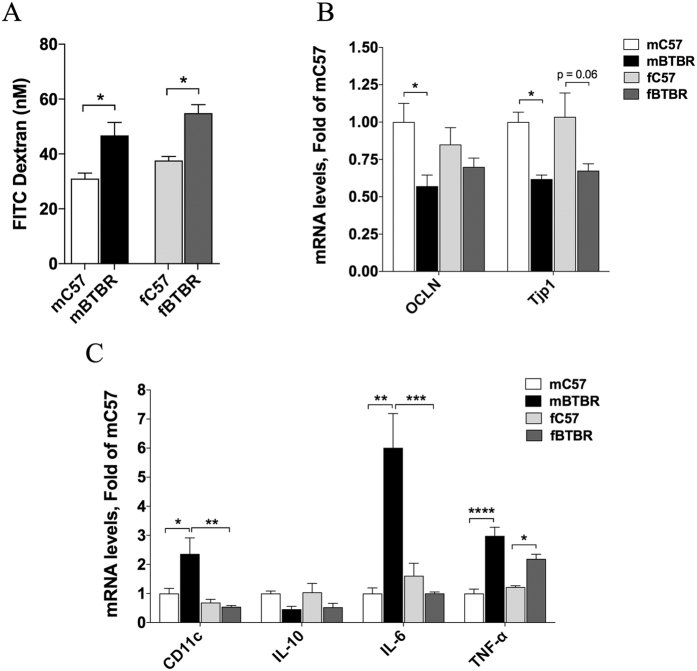
Analysis of intestinal integrity and inflammation levels in female and male BTBR mice.(A) Intestinal epithelial permeability to fluorescein isothiocyanate (FITC)-dextran 4 kDa of BTBR and C57 mice of both sexes. Data are represented as plasma concentration of FITC dextran (nM) (n = 5/group; p = 0.0002 for strain, p = 0.0469 for sex and p = 0.8187 for strain x sex, by two-way ANOVA). (B) Colon occludin (OCLN) and zonuline-1 (Tjp1), gene expression normalized to GAPDH gene in BTBR and C57 mice of both sexes. Data were normalized to mC57 control (n = 6/group; OCLN: p = 0.0067 for strain, p = 0.9105 for sex and p = 0.1623 for strain x sex; Tjp1: p = 0.0004 for strain, p = 0.6202 for sex and p = 0.9105 for strain x sex, by two-way ANOVA). (C) Colon mRNA levels of inflammatory markers (CD11c, IL-10, IL-6 and TNF-alpha) normalized to GAPDH in BTBR and C57 mice of both sexes. Data for each gene were normalized to mC57 controls (n = 6/group; CD11c: p = 0.0529 for strain, p = 0.0018 for sex and p = 0.019 for strain x sex; IL-10: p = 0.0041 for strain, p = 0.7827 for sex and p = 0.9739 for strain x sex; IL-6: p = 0.0106 for strain, p = 0.0107 for sex and p = 0.002 for strain x sex; TNF-alpha: p < 0.0001 for strain, p = 0.2196 for sex and p = 0.0354 for strain x sex, by two-way ANOVA). In bar charts all data are expressed as mean values ± SEM; significant differences are indicated by *p < 0.05, **p < 0.01, ***p < 0.001 and ****p < 0.0001; near-significant differences are also reported (Bonferroni post-hoc tests following two-way ANOVA with strain and sex as factors). Abbreviations: fBTBR (BTBR female mice); mBTBR (BTBR male mice); fC57 (C57 female mice); mC57 (C57 male mice).